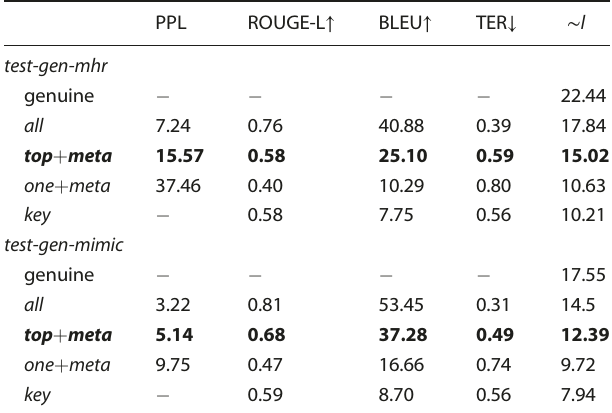
Table 2. Qualitative evaluation and average sentence lengths on the CRIS data ( test-gen-mhr ) and the MIMIC-III data ( test-gen-mimic ). Models providing data closest to the original data according to all the scores are highlighted in bold.